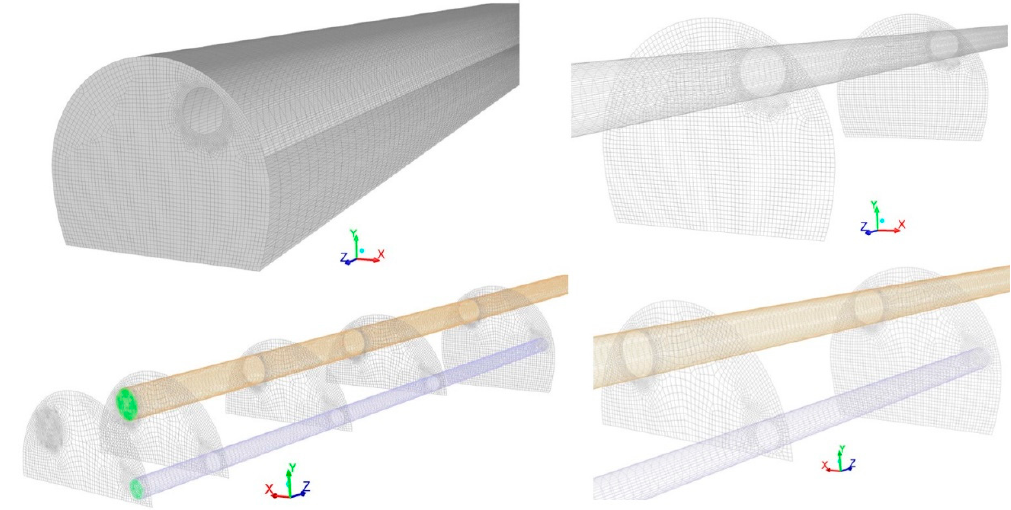
Figure 4. Model grid and boundary conditions, including the tunnel walls, cross-sectional areas and ventilation ducts (forced and exhaust systems).